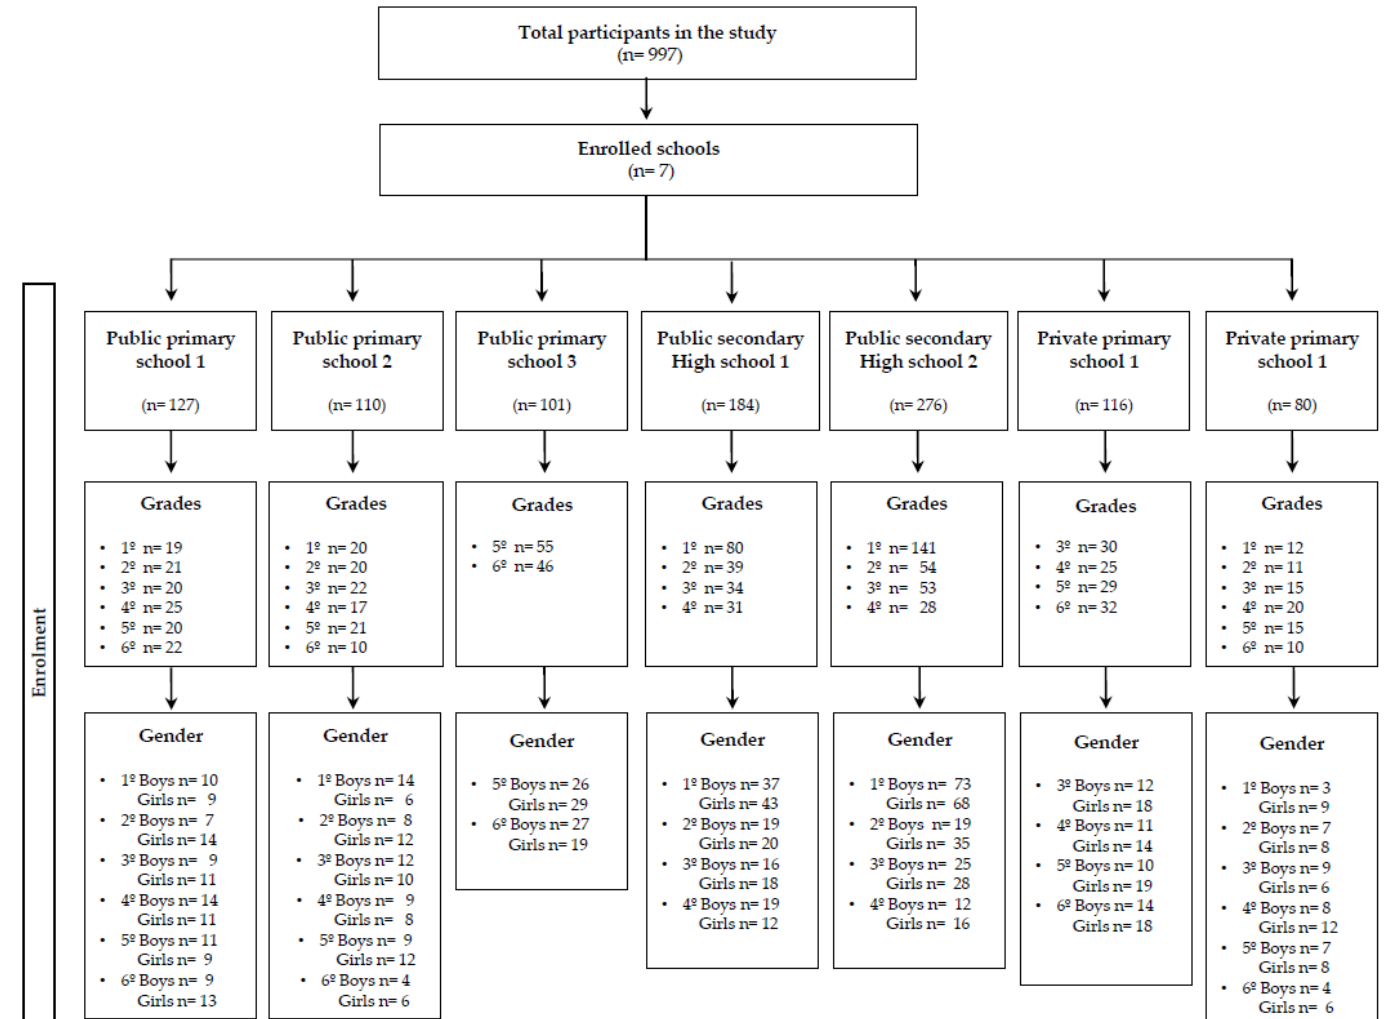
Figure 1. Flow diagram of the study participants.